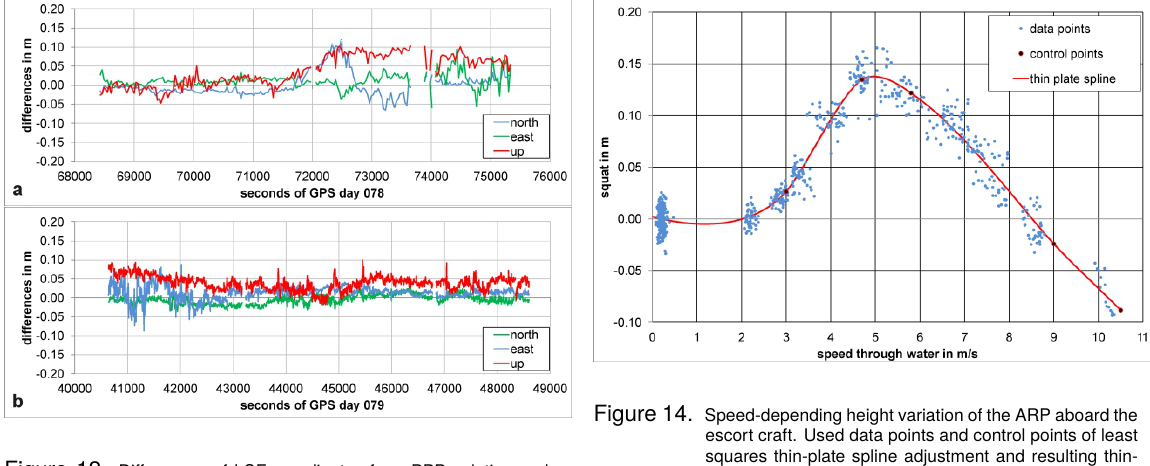
Figure 12. Differences of LCF coordinates from PPP solution and relativekinematicprocessingfordeparture(a) andarrival (b).